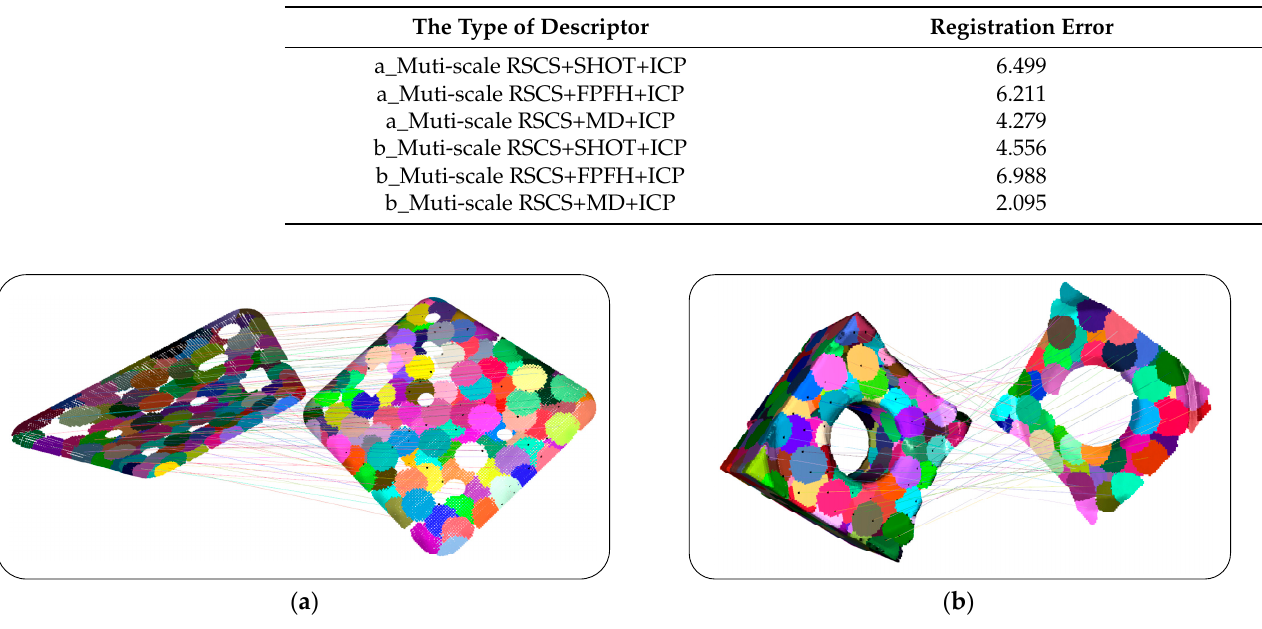
Figure 17. The matching relation of point cloud patch in Multi-scale RSCS+MD ( a ) part 1; ( b ) part 2.